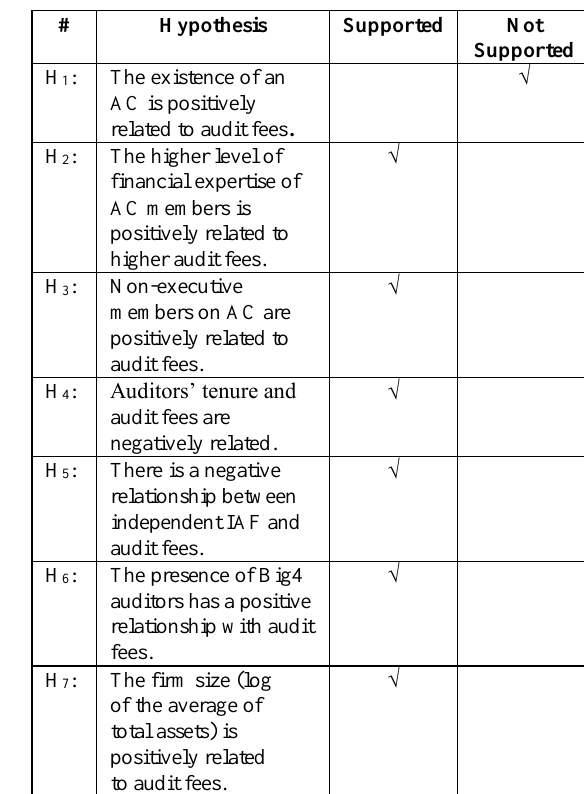
Table 5: Testing for